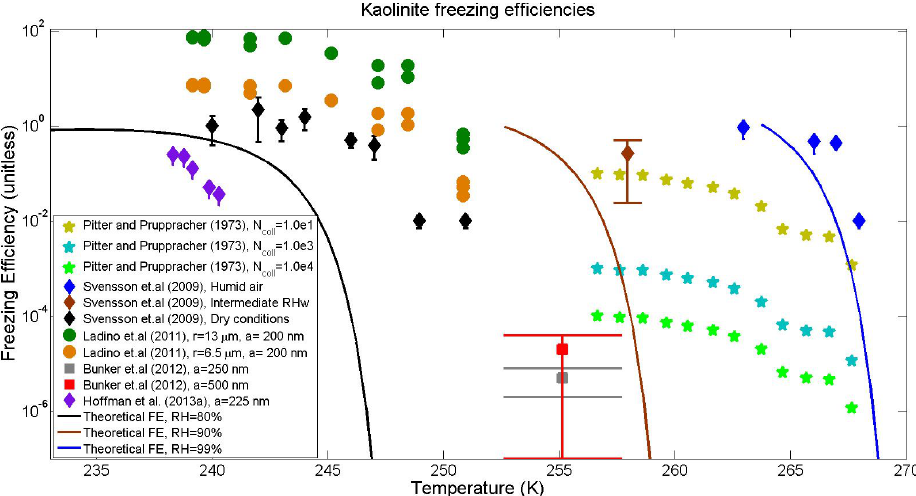
Fig. 12. Comparison of the available kaolinite freezing efficiencies due to contact nucleation as a function of temperature from different instrumentation. In those studies that reported frozen fractions we have calculated the freezing efficiency, assuming different values for N coll . The stars represent the wind tunnel data with different assumptions for the unknown parameter N coll (Pitter and Pruppacher, 1973), whereas the diamonds, circles and squares depict the data from the EDB (Svensson et al., 2009; Hoffmann et al., 2013b), CLINCH (Ladino et al., 2011b) and the cold plate data (Bunker et al., 2012), respectively.